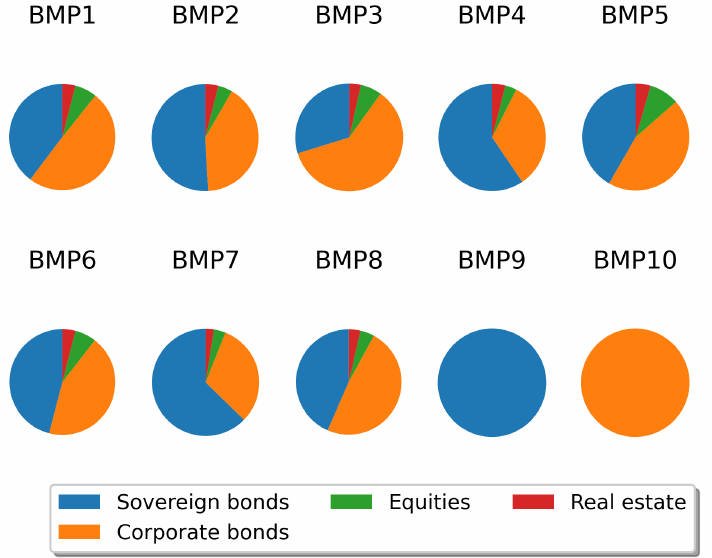
Figure 1. Composition of the MCRCS asset-only benchmark portfolios BMP1–BMP10. The two liability profiles are assumed to be zero-bond based, so they represent the liabilities of non-life insurance companies and differ in their durations (13.1 years vs. 4.6